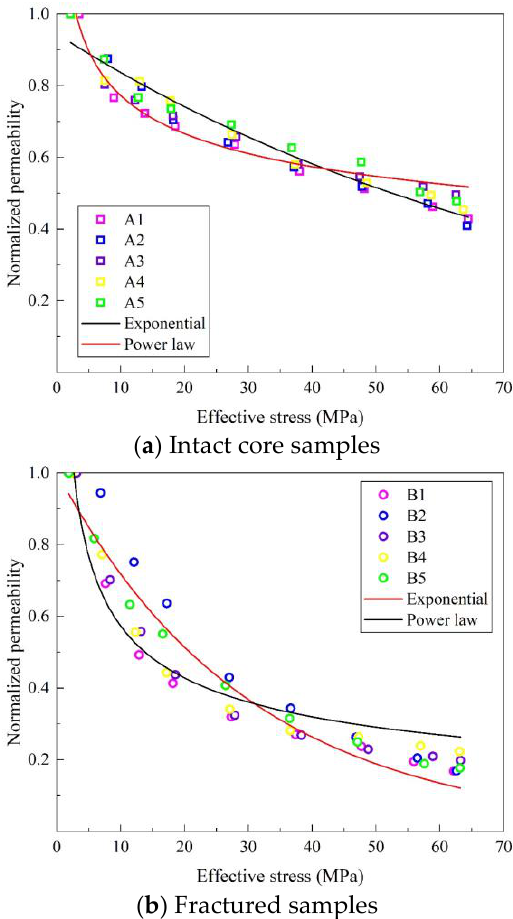
Figure 3. Fitted curves of permeability vs. effective stress.